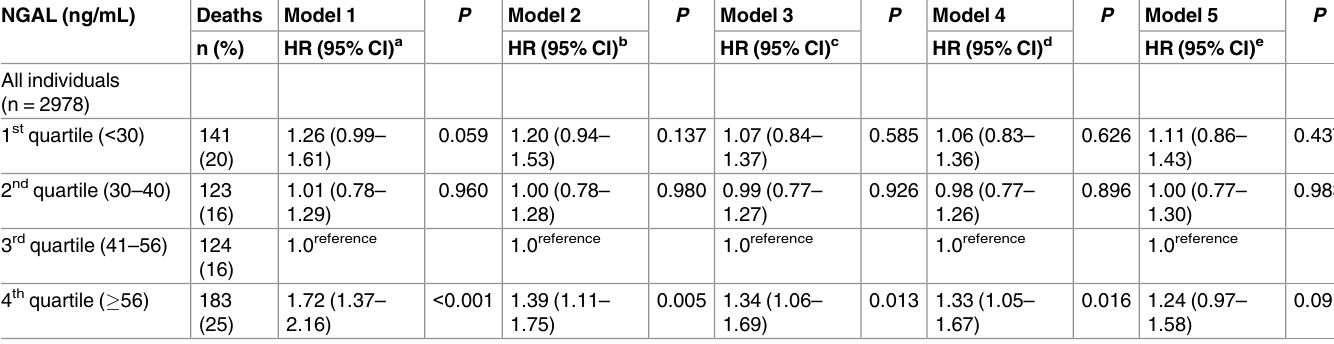
Table 4. Hazard ratios (HR) for death from cardiovascular causes according to